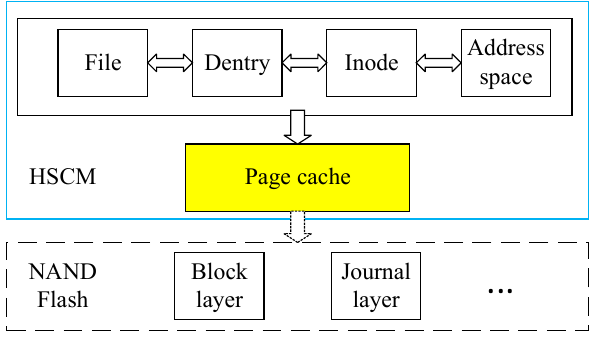
Figure 7. File system for HSCM.